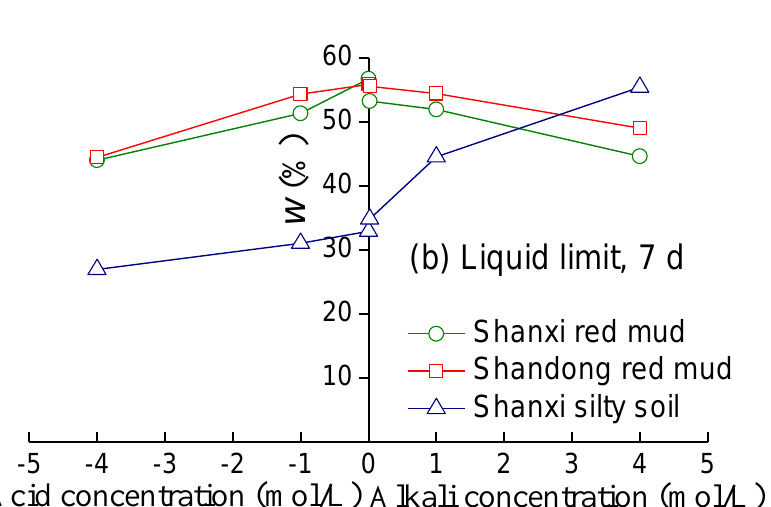
Figure 2. The limit water content as a function of the HCl or NaOH solution concentration—( a ) plastic limit, and ( b ) liquid limit.